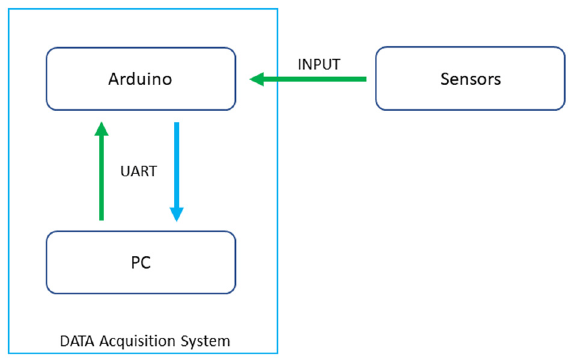
Figure 3. Data acquisition system hardware diagram.